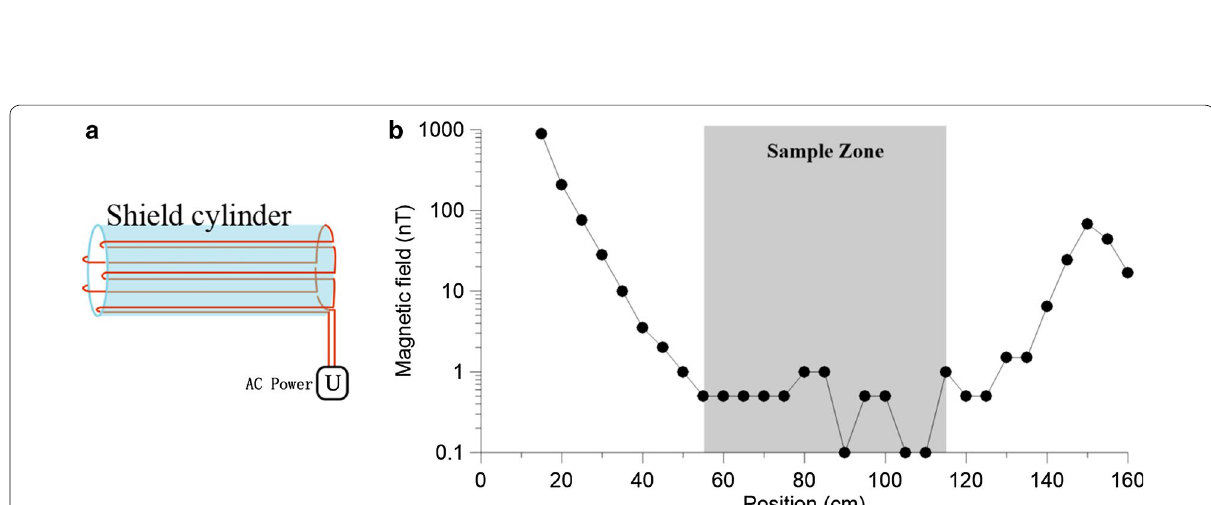
Fig. 8 a Toroidal degaussing coil embodying the shield cylinder. b Residual fields (black circles) along longitude axis in the newly designed